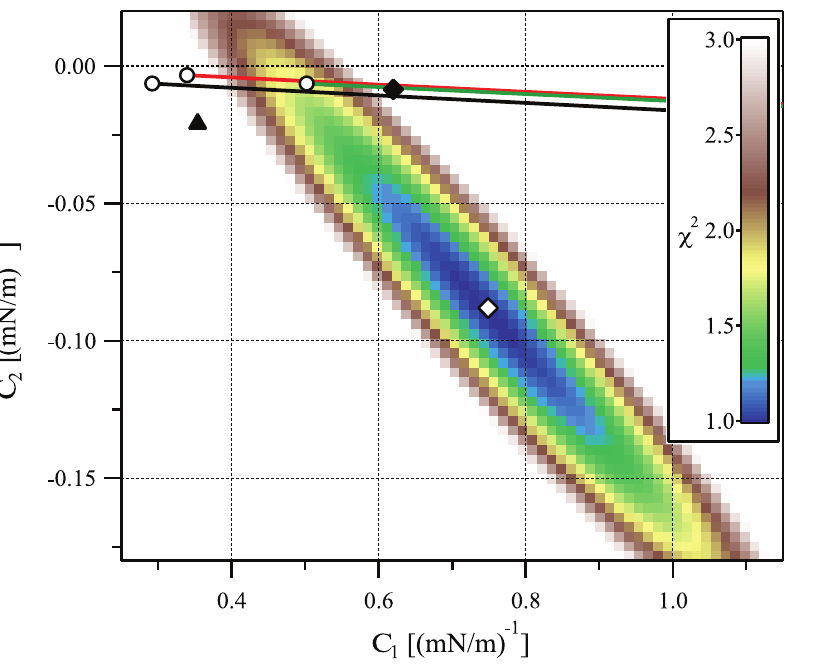
Figure 8. Comparison between the experimental values of C 1 and C 2 and those obtained from different models. Colorscale: goodness- of-fit function x 2 (see Eq. 19) for the data of Ref. [18], as a function of the fitting parameters C 1 and C 2 . White diamond: values of C 1 and C 2 that give the best fit. Black triangle: results obtained from the elastic model of Ref. [22], with the constants given in [18]. Lines: trajectories obtained from our model in the ( C 1 , C 2 ) plane when varying k ’ a . Red: free slope; green: s ~ 0 , black: s ~ 0 : 3 . These three curves start by a white dot at k ’ a ~ 0 , and k ’ a increases rightwards along these curves. The rightmost white dot ( k ’ a ~ 0 , s ~ 0 ) roughly corresponds to the best agreement we can obtain between our model and the experiment fitted to the quadratic model (red curve on Fig. 7). The black diamond corresponds to the best agreement we can obtain between our model and the experiment fitted to the linear model at low tension (see Fig. 9).